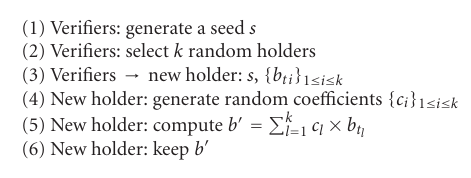
Figure 5: Repair phase: construction of a new coded block.